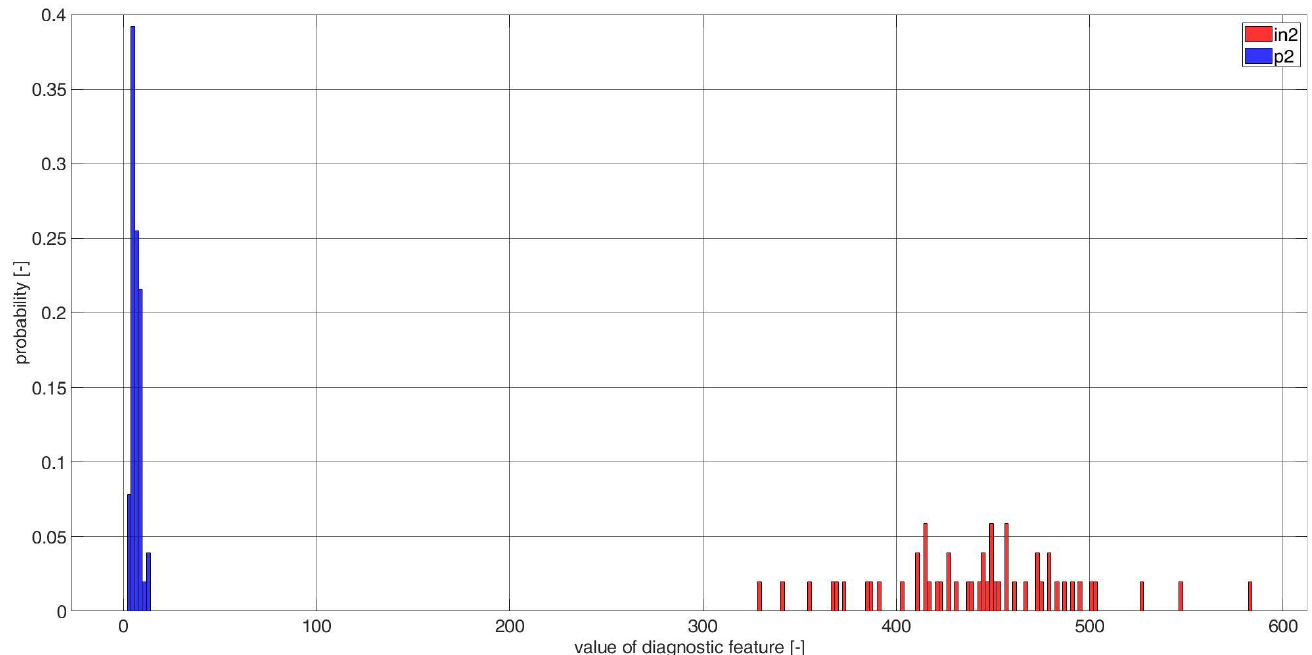
Figure A19. Histograms of diagnostic features based on the CCSM3 (correlation number is 21— Table A1) bearings in1 and p1. Table A1) bearings in1 and p1.